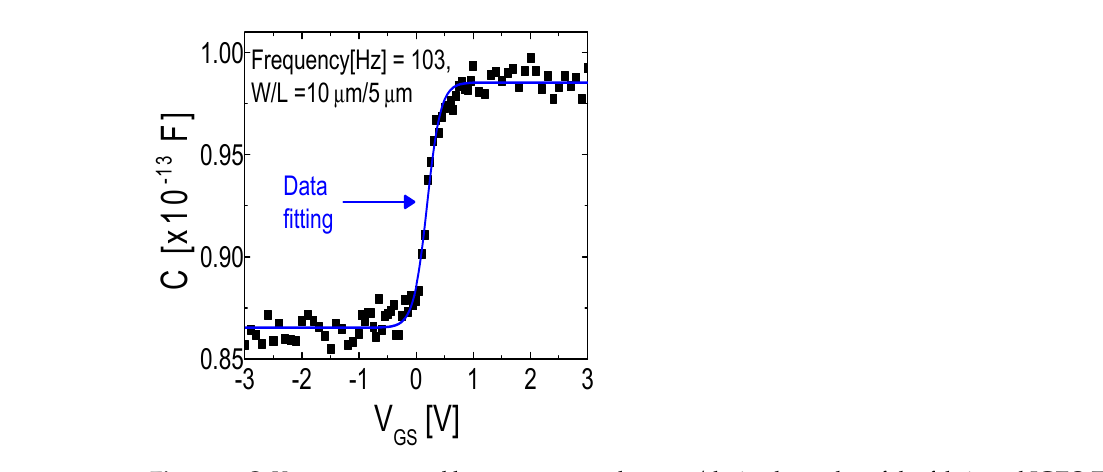
Figure 4. C – V curve measured between gate and source/drain electrodes of the fabricated IGZO TFT at 103 Hz.